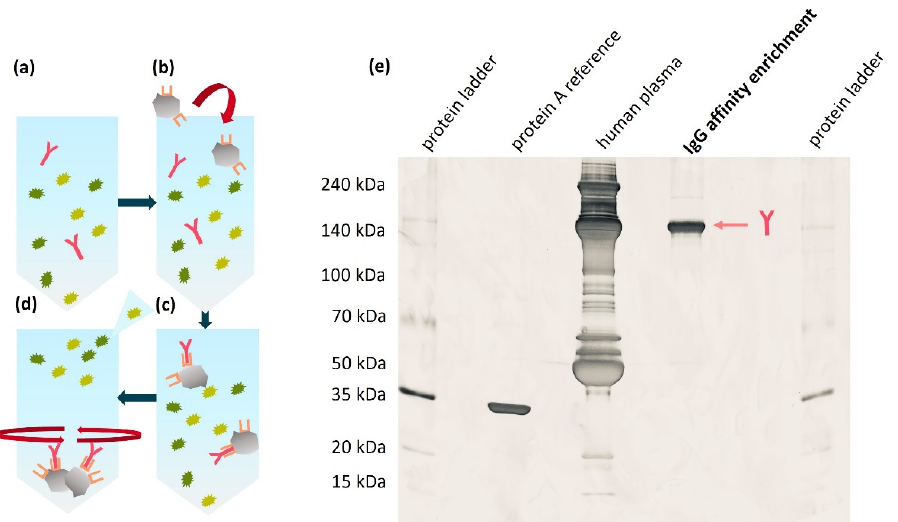
Figure 5. Affinity enrichment of IgG (Y symbol) from human plasma. Corundum was coated with 12-APA and oxidized polyglycerol: (a) Human plasma containing a high number of different proteins, (b) incubation with protein-A-functionalized corundum, (c) binding of IgG to protein A (u symbol), (d) centrifugation, and removal of the supernatant and washing, and (e) SDS-PAGE after the elution of selectively bound IgG by a 2% SDS solution.